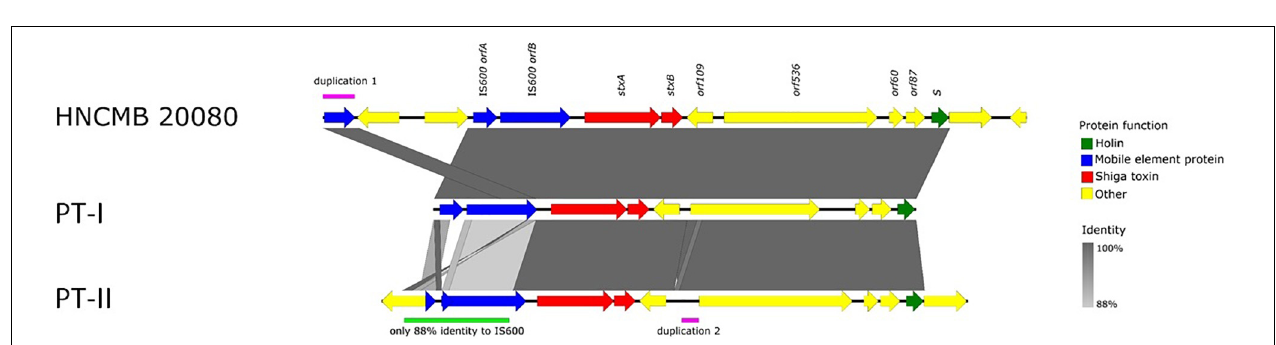
FIGURE 2 | Schematic representation of the two types of Stx1-prophages present in the genomes of SD1 strains.